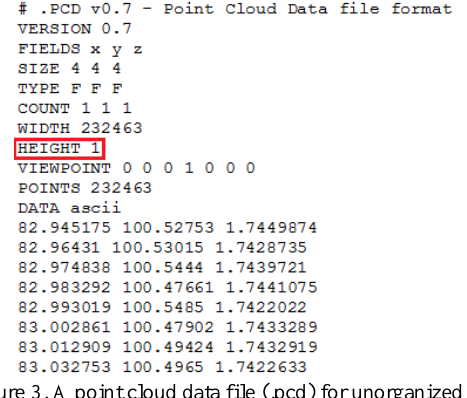
Figure 3. A point cloud data file (.pcd) for unorganized point cloud